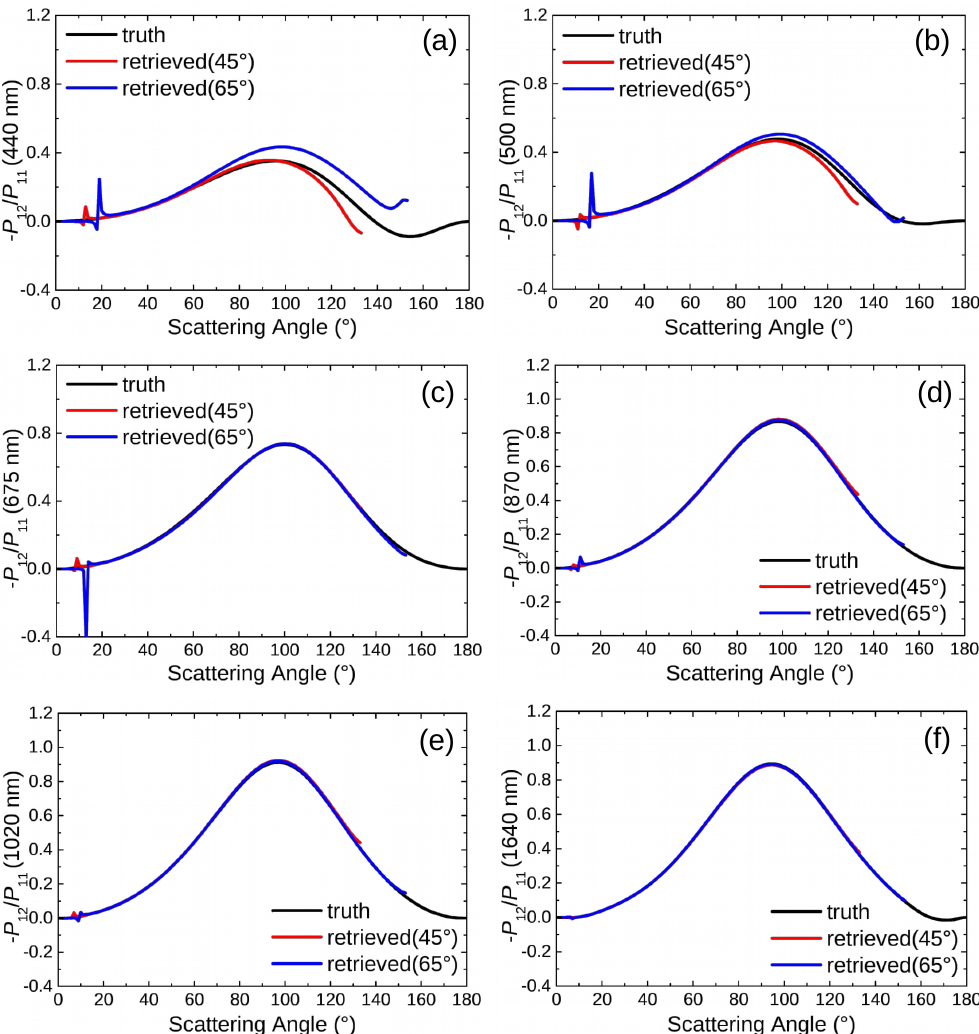
Figure 2. Comparison of - P 12 / P 11 retrieved from the Stokes parameter Q at different solar zenith angles for the principal plane observation geometry. The curve notation is as: red solid lines for results with SZA of 45 0 ; blue solid lines for results with SZA of 65 0